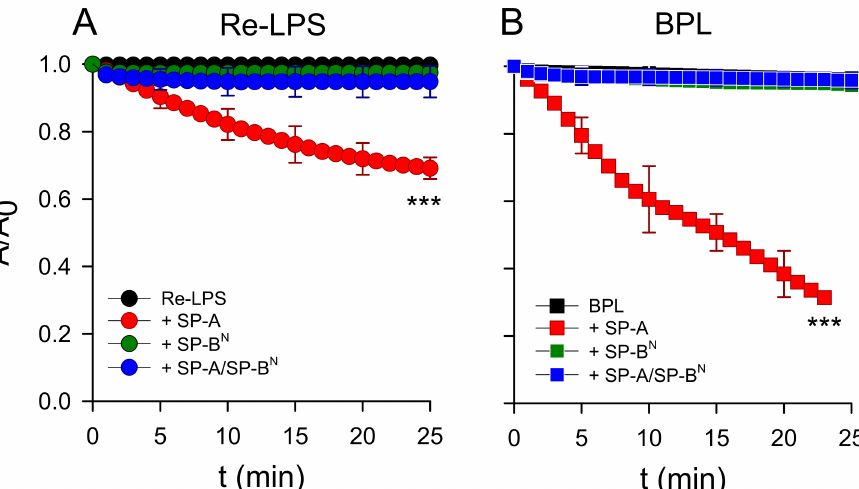
Figure 7. Effect of SP-A (1.54 nM) and/or SP-B N (12.5 nM) on the relaxation kinetics of the Re- LPS ( A ) and BPL ( B ) monolayers spread onto a saline subphase during t = 30 min at a constant surface pressure (32 mN/m). The temperature of the subphase was 25.0 ± 0.1 ◦ C. The results are the mean ± SD of three experiments. A p -value < 0.001 was obtained for the overall one-way ANOVA (Bonferroni-corrected p -value: *** p < 0.001 when compared to the